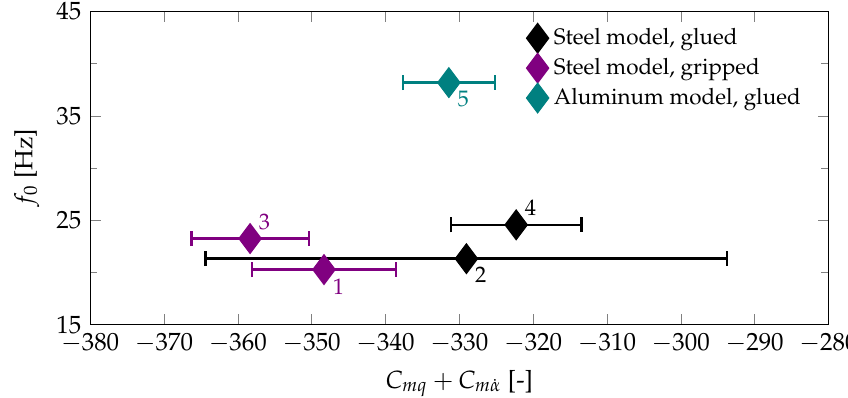
Figure 12. Oscillation frequency over C mq + C m ˙ α for the Basic Finner at Mach 0.6 (numvbers according to Table